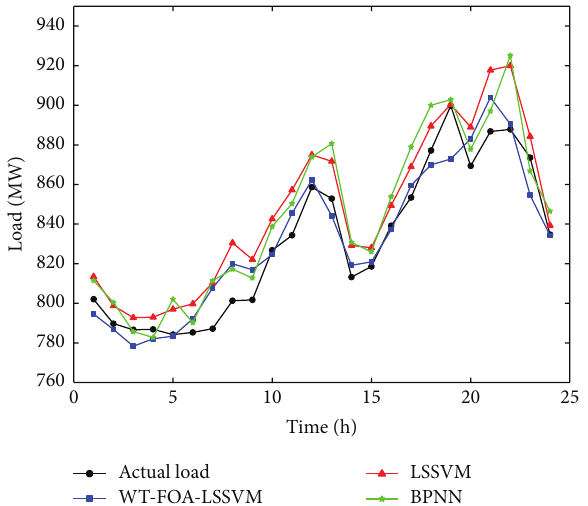
Figure 10: Relative errors of WT-FOA-LSSVM, FOA-LSSVM, and PSO-LSSVM.